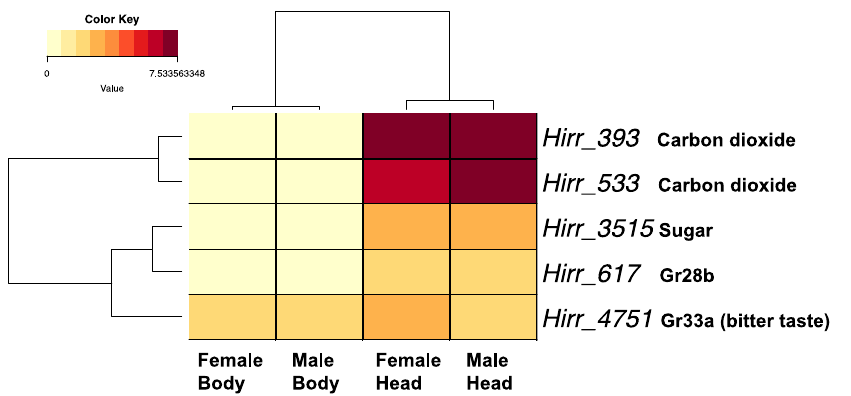
Figure 9. Heat map and hierarchical clustering dendrogram of Haematobia irritans candidate GR transcripts in female and male head appendages (Head) and headless bodies (Body). Log-transformed TPM values were used to construct the heat map. These five represent the most abundantly expressed transcripts encoding GRs. Dendrogram reflects transcripts with similar expression patterns, identified by hierarchical clustering applied to expression values (rows) and dataset categories